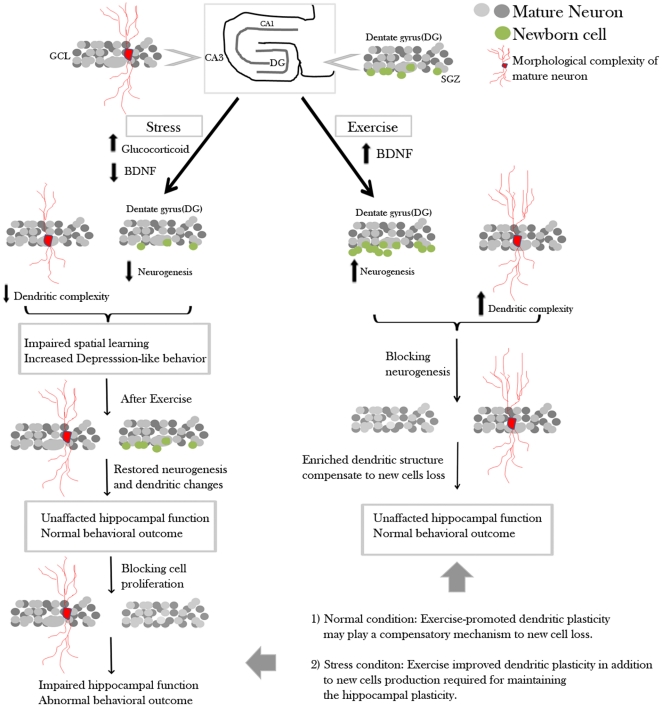
Schematic diagram showing the hypothesis of the counteracting mechanism of running on stress.Exposure to stress increases glucocorticoid level and decreases BDNF, which results in decreased hippocampal neurogenesis and dendritic retraction. In normal rats, existing neurons may be able to maintain hippocampal plasticity. In stressed rats, intact hippocampal plasticity, which maintained by continuous production of new neurons and dendritic remodeling, may mediate the beneficial effects of running on stress.